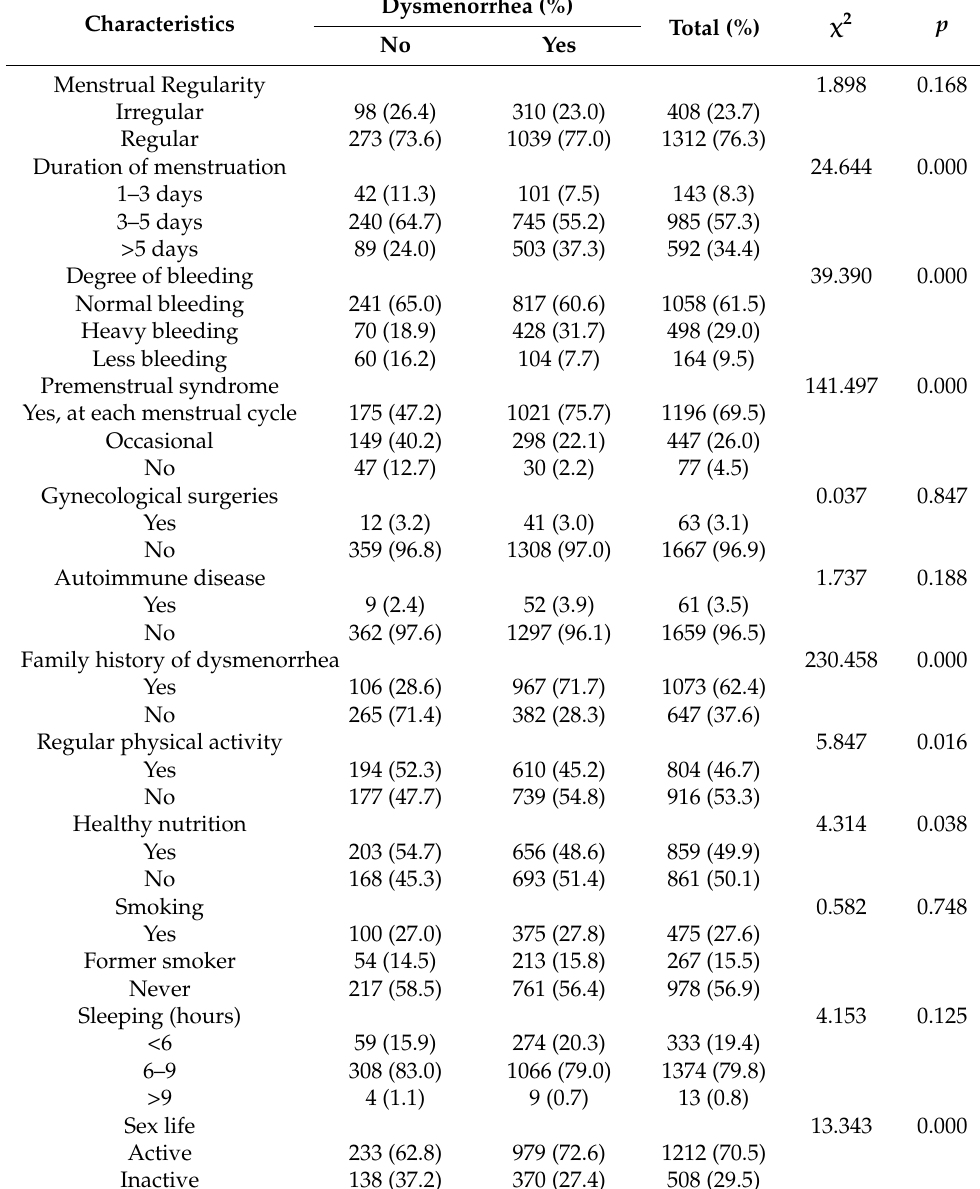
Table 1. Characteristics of Female Students ( n =